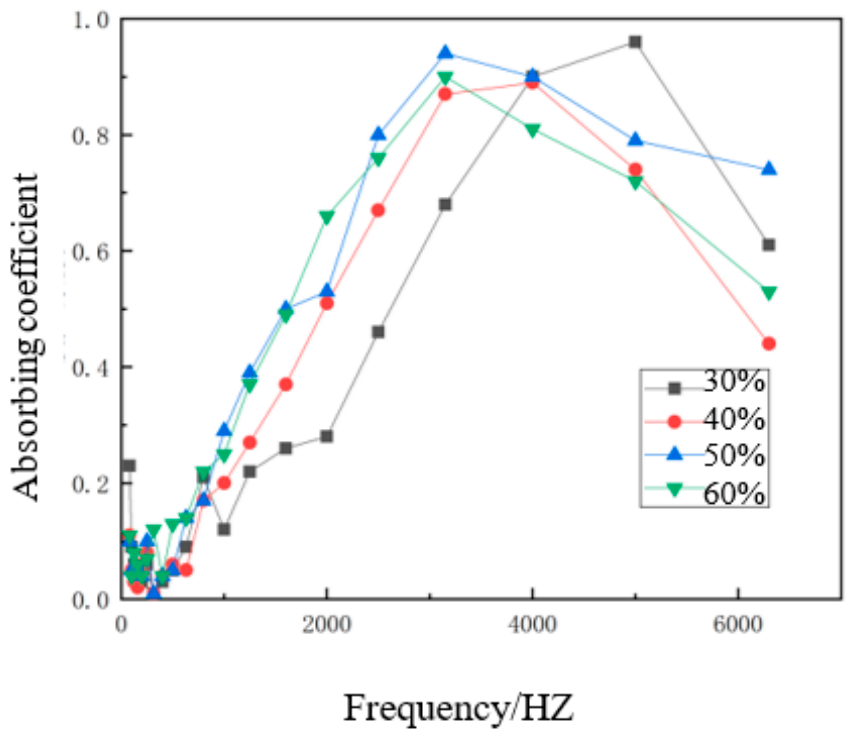
Figure 9. Sound absorption coefficient curves for different hemp stalk mass fractions.